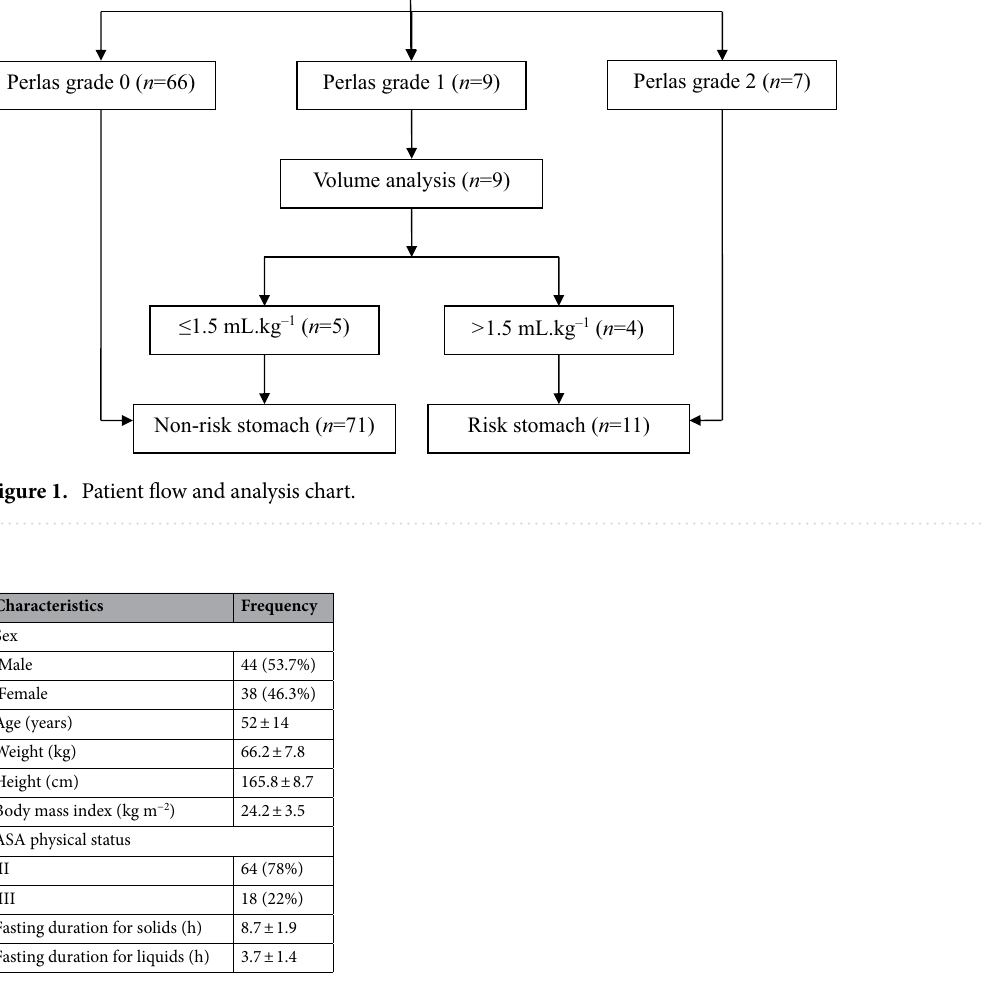
Table 1. Baseline characteristics of the participants included in final analysis. Values are presented as n (%) or mean ±